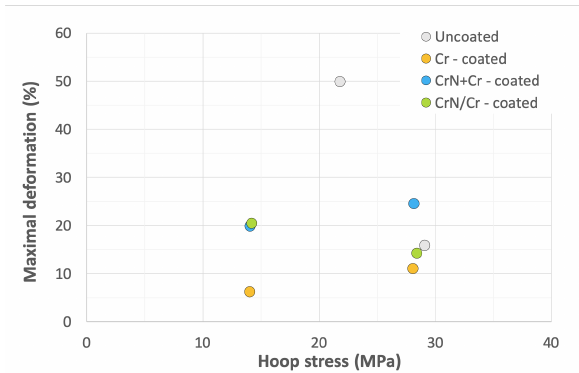
Figure 4. Maximal deformation at temperature 1100 ◦ C in relation to hoop stress for different types of coatings and uncoated specimens